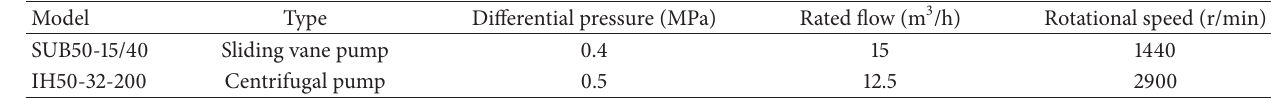
Table 1: Parameters of